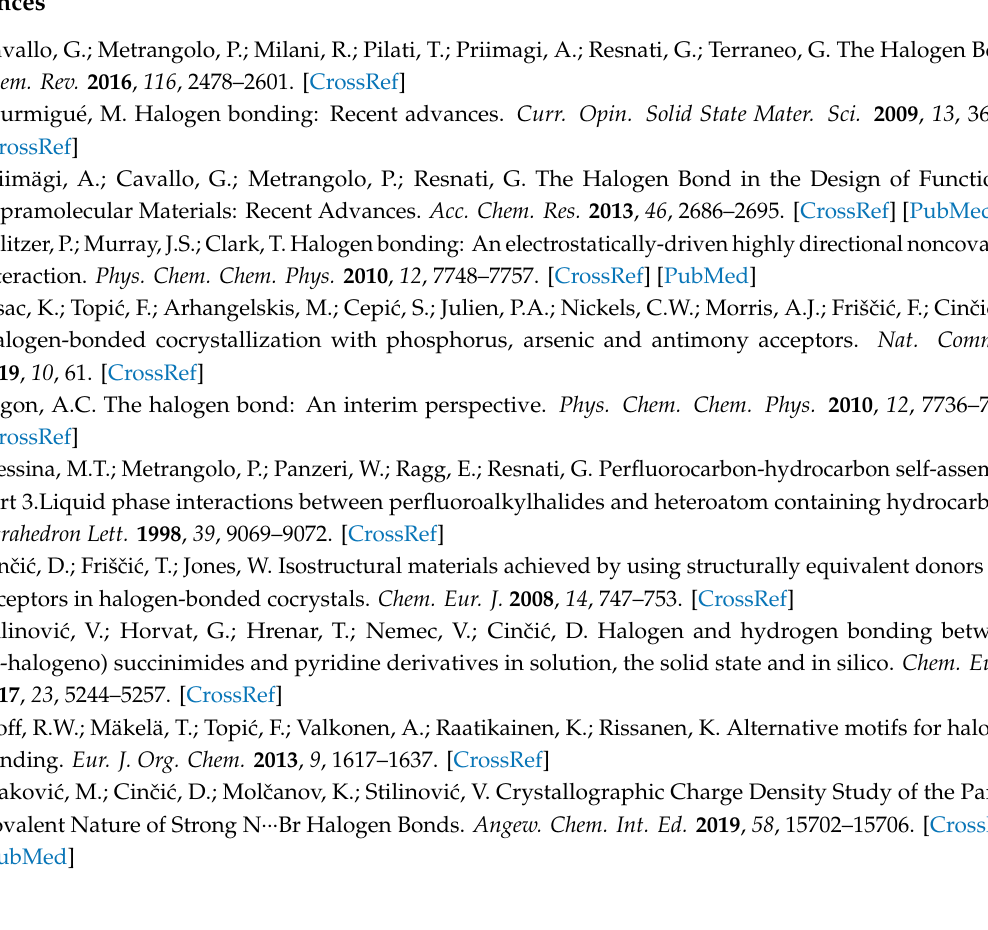
Figure S1: PXRD patterns of (a) CuCl 2 ( aap ) 2 , (b) 14tfib , (c) product obtained by grinding CuCl 2 ( aap ) 2 and 14tfib in a 1:1 stoichiometric ratio, (d) calculated pattern from [CuCl 2 ( aap ) 2 ]( 14tfib ) single crystal data, Figure S2: PXRD patterns of (a) CuCl 2 ( aap ) 2 , (b) 12tfib , (c) product obtained by grinding CuCl 2 ( aap ) 2 and 12tfib in a 1:2 stoichiometric ratio, (d) product obtained by grinding CuCl 2 ( aap ) 2 and 12tfib in a 1:1 stoichiometric ratio. Stars denote small peaks not belonging to either reactant, Figure S3: PXRD patterns of (a) CuCl 2 ( aap ) 2 , (b) product obtained by grinding CuCl 2 ( aap ) 2 and 13tfib in a 1:1 stoichiometric ratio, Figure S4: PXRD patterns of (a) 135tfib , (b) CuCl 2 ( aap ) 2 , (c) product obtained by grinding CuCl 2 ( aap ) 2 and 135tfib in a 1:1 stoichiometric ratio, Figure S5: Molecular structure of CuCl 2 ( aap ) 2 showing the atom-labelling scheme. Displacement ellipsoids are drawn at the 50% probability level, and H atoms are shown as small spheres of arbitrary radius. Symmetry codes of symmetry equivalent atoms marked with an (cid:48) symbol are listed in Table S4, Figure S6: Molecular overlay of the metal complex molecule obtained from CuCl 2 ( aap ) 2 data (colored red) with the metal complex molecule obtained from [CuCl 2 ( aap ) 2 ]( 14tfib ) data (colored blue). The metal complex structures are in good agreement with a root mean square deviation (RMSD) value of 0.1418 and a maximum distance of 0.2619, Figure S7: TG and DSC curves of CuCl 2 ( aap ) 2 , Figure S8: TG and DSC curves of [CuCl 2 ( aap ) 2 ]( 14tfib ), Table S1: Mechanochemical synthesis parameters, Table S2: Crystal data and refinement details for the prepared compounds, Table S3: Parameters of Table S4: Atom list and symmetry codes of symmetry equivalent atoms (marked with an (cid:48) symbol) in the prepared compounds. CCDC 1997629 and 1997630 contain crystallographic data for this paper. These data can be obtained free of charge from the Director, CCDC, 12 Union Road, Cambridge, CBZ 1EZ, UK (Fax: + 44-1223-336033;